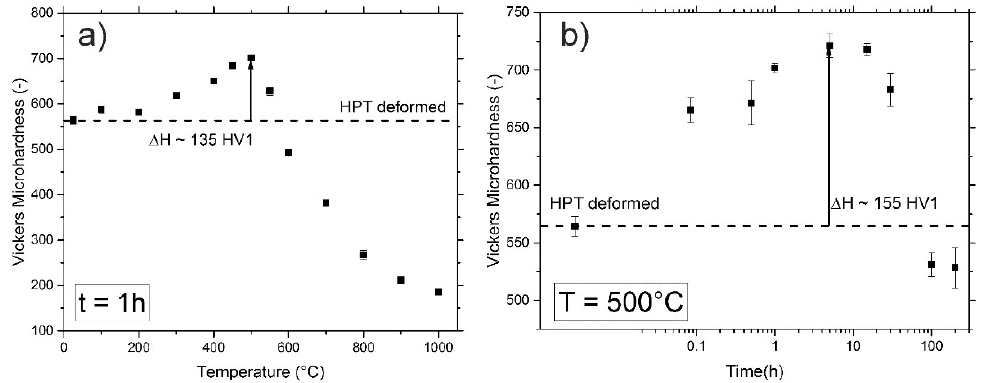
Figure 4. ( a ) Hardness evolution during isochronal heat treatment (t = 1 h) for temperatures between 100 °C and 1000 °C. ( b ) Changes in hardness during isothermal annealing at 500 °C for times ranging from 5 min to 200 h.